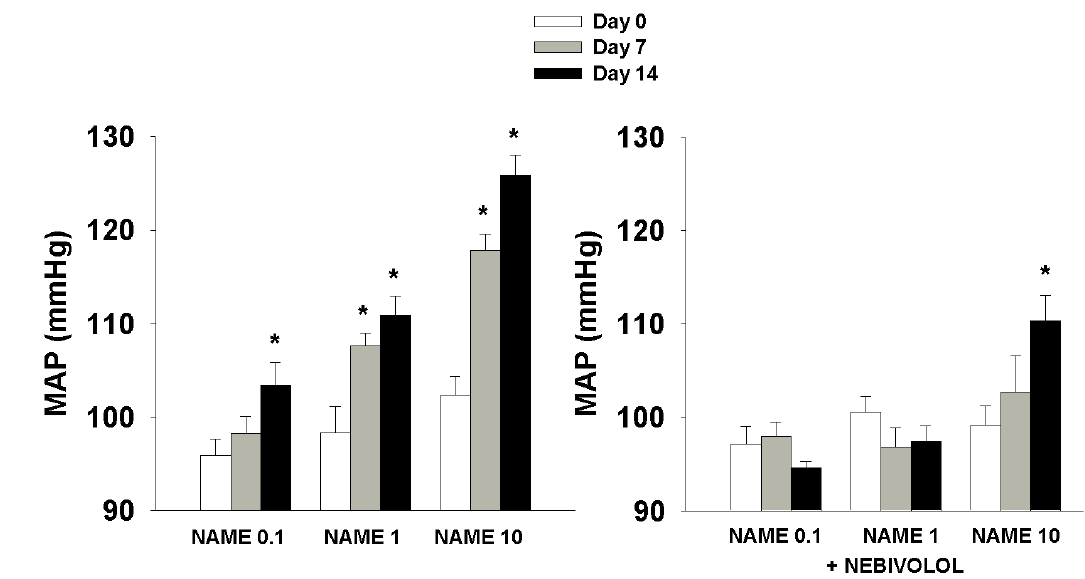
FIGURE 1 . Time-dependent changes in mean arterial pressure (MAP) in the experimental groups. *, p < 0.05 vs. day 0.